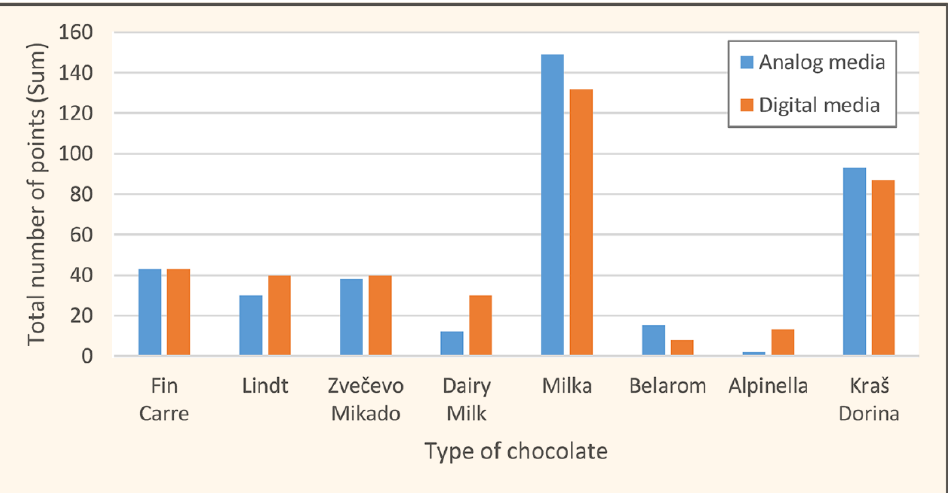
Figure 4. Graphic representation of product selection distribution frequencies on analog media in relation to digital media.